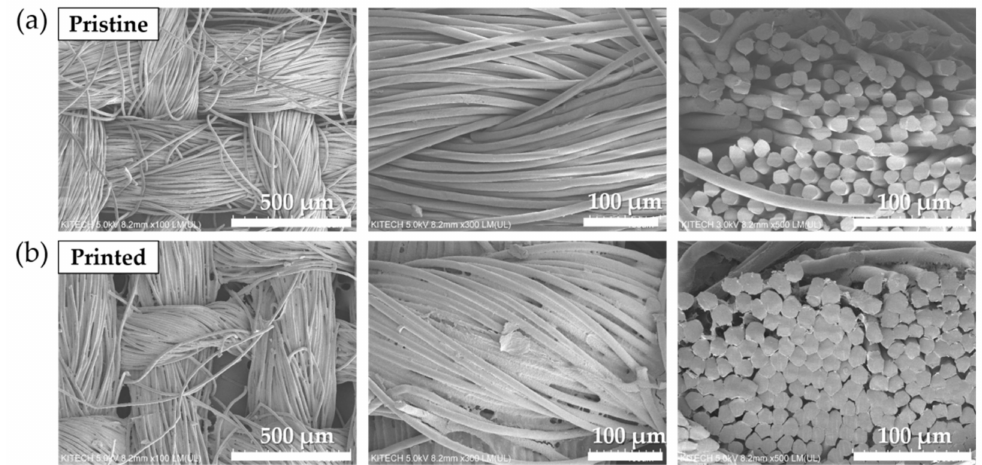
Figure 5. FE-SEM image of the fabricated textile sensor with mixed-dyes (Dye 3 / RhYK): ( a ) Pristine polyester fabric, ( b ) Printed polyester